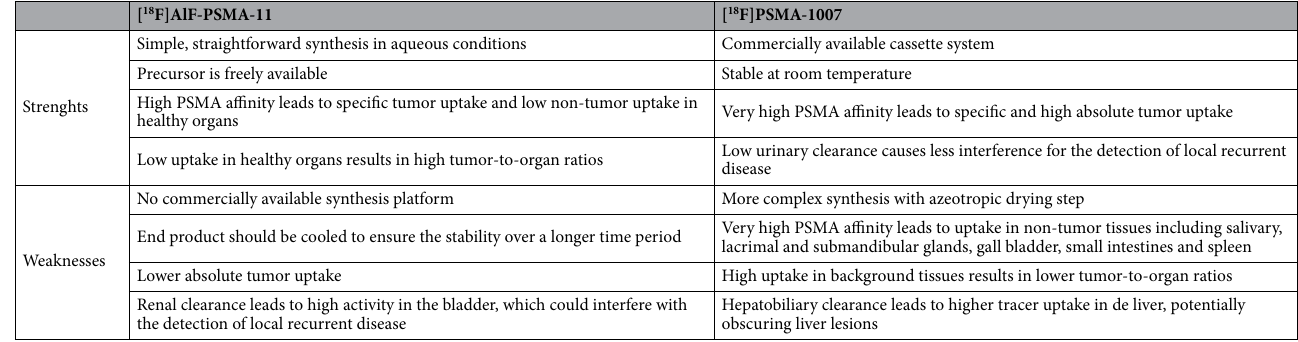
Table 3. Overview of the strengths and weaknesses of [ 18 F]AlF-PSMA-11 and [ 18